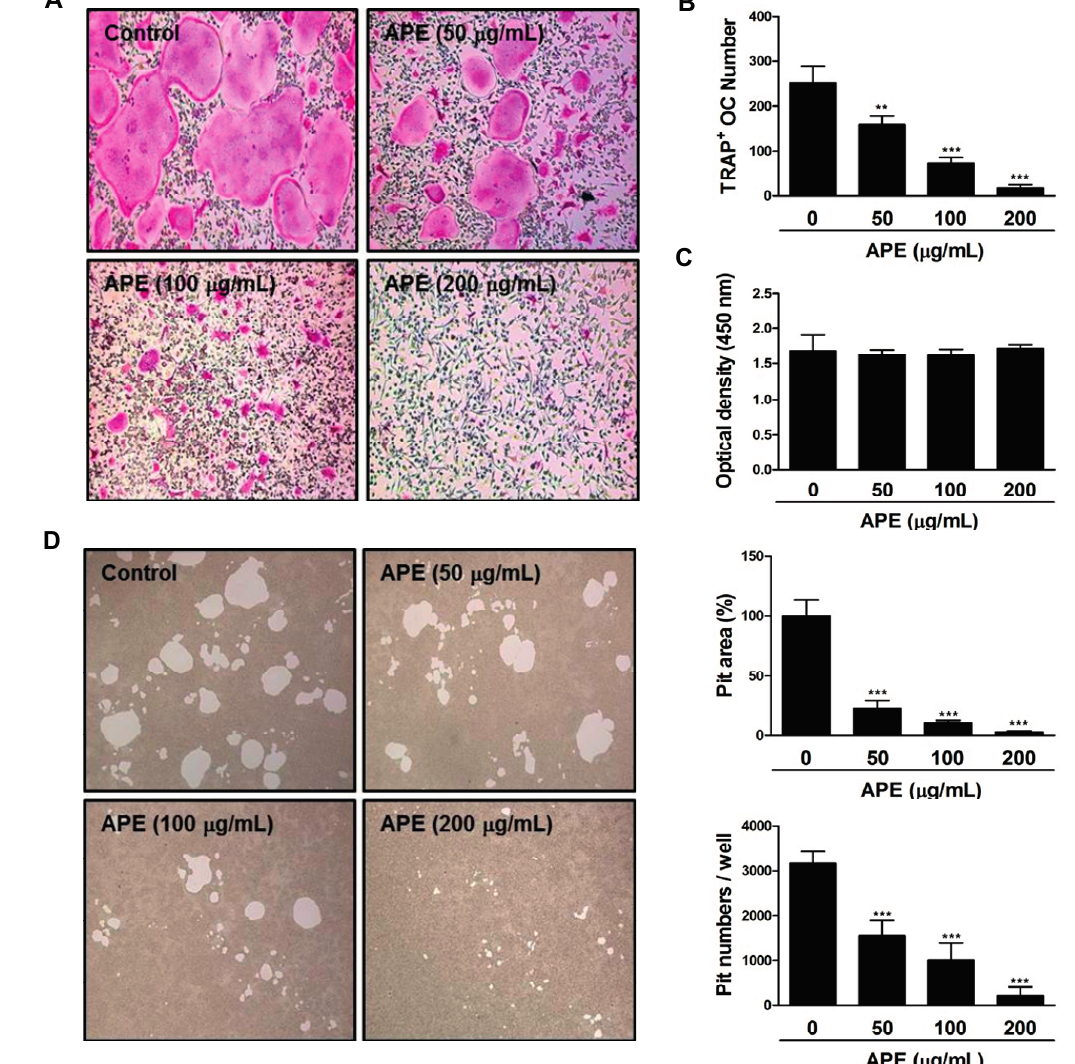
Figure 3. Aconitum pseudo-laeve var. erectum (APE) inhibits the formation of tartrate- resistant acid phosphatase (TRAP)-positive osteoclasts, as well as the bone resorbing activity of mature osteoclasts. ( A ) Bone marrow macrophages (BMMs) were cultured for 4 days in the presence of macrophage colony-stimulating factor (M-CSF; 30 ng/mL) and receptor activator of nuclear factor kappa-B ligand (RANKL; 100 ng/mL) with dimethyl sulfoxide (DMSO; control) or APE. Cells were fixed with 3.7% formalin in phosphate-buffered saline (PBS), permeabilized with 0.1% Triton X-100 in PBS and stained with TRAP solution; ( B ) TRAP-positive multinucleated cells were counted as osteoclasts; ( C ) BMMs were cultured for 3 days at the indicated doses of APE in the presence of M-CSF (30 ng/mL). Cell viability was analyzed by XTT assay; ( D ) Mature osteoclasts were seeded on hydroxyapatite-coated plates for 24 h with the indicated concentrations of APE. Attached cells on the plates were removed and photographed under a light microscope. The relative ratio and number of pit areas was quantified using Image